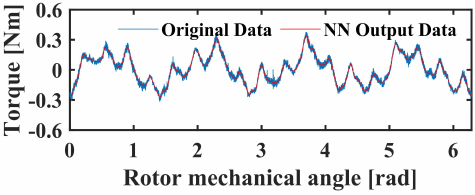
Figure 6. The actual torque ripple waveform and output of the trained NN at the speed of 60